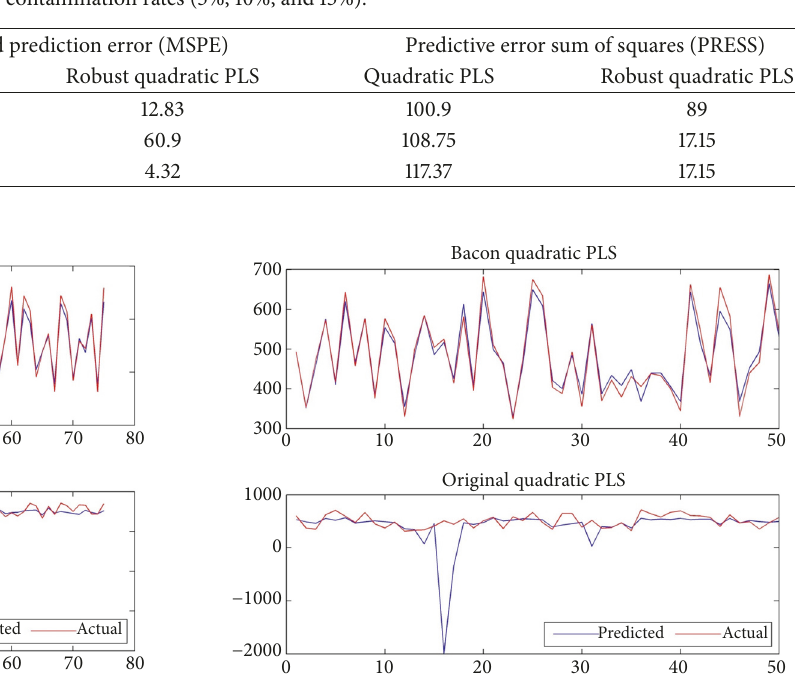
Figure 1: Comparison of predicted and actual values of test dataset in case of quadratic and robust quadratic PLS regression on 5% contaminated data.